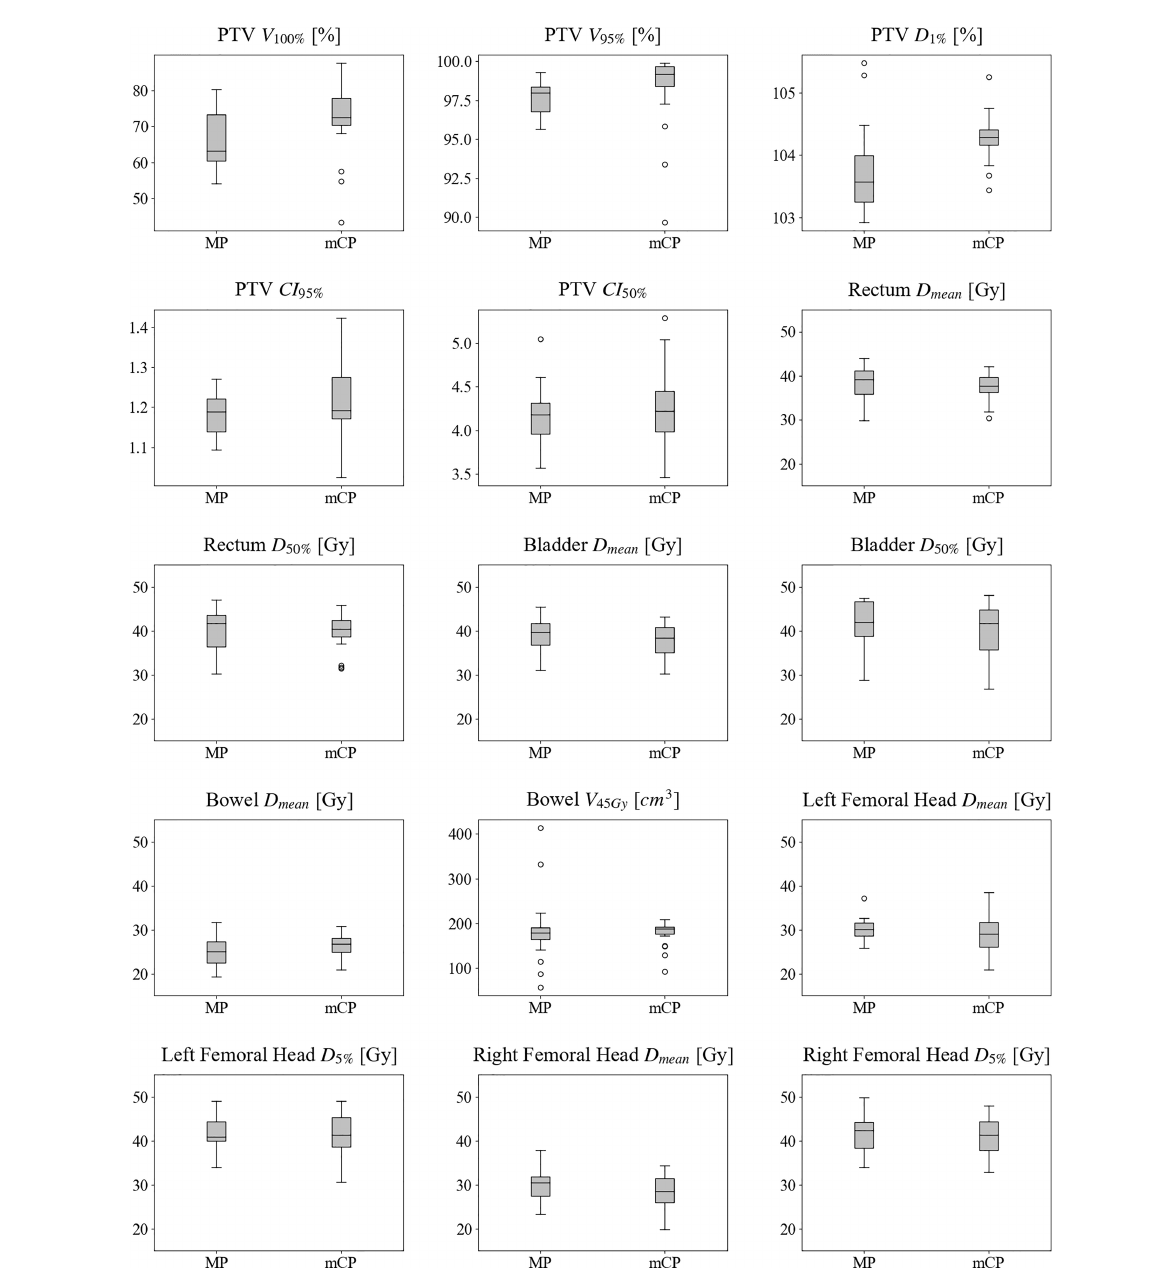
FIGURE 2 Box-and-whisker plots of computed dosimetric metrics for manual plans and mCycle plans. The box is delimited by the fi rst (25%) and the third (75%) quartiles, and the bold line represents the median value. The whiskers point to the minimum and maximum data without counting boxplot outliers that in case there exist are represented with circles. An outlier is de fi ned as a value exceeding the 1.5 interquartile range [1.5 (third – fi rst quartile)]. MP, manual plans; mCP, mCycle plans; PTV, planning target volume; V # , volume receiving more than # Gy; D # , dose received by the # % of contoured volume; CI # , conformality index of the # dose; D mean , mean